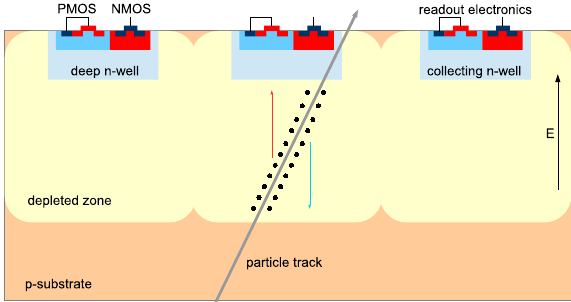
Figure 2. Diagram of a depleted Complementary Metal-Oxide-Semiconductor (CMOS) depleted monolithic active pixel sensors (DMAPS)